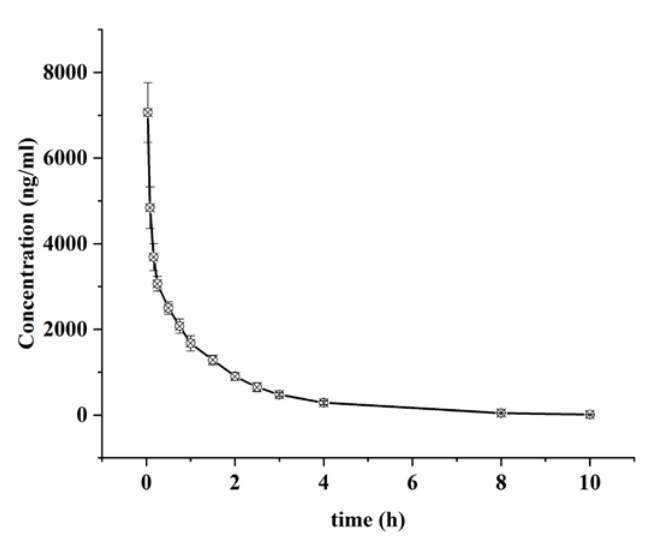
Figure 3. The mean plasma concentration-time curves of alnustone after the intravenous administration of alnustone at a dose of 5 mg/kg ( n = 12, mean ± SD). Table 5. Non-compartmental plasma pharmacokinetic parameters following a single intravenous administration of alnustone (5 mg/kg) to rats ( n = 12).